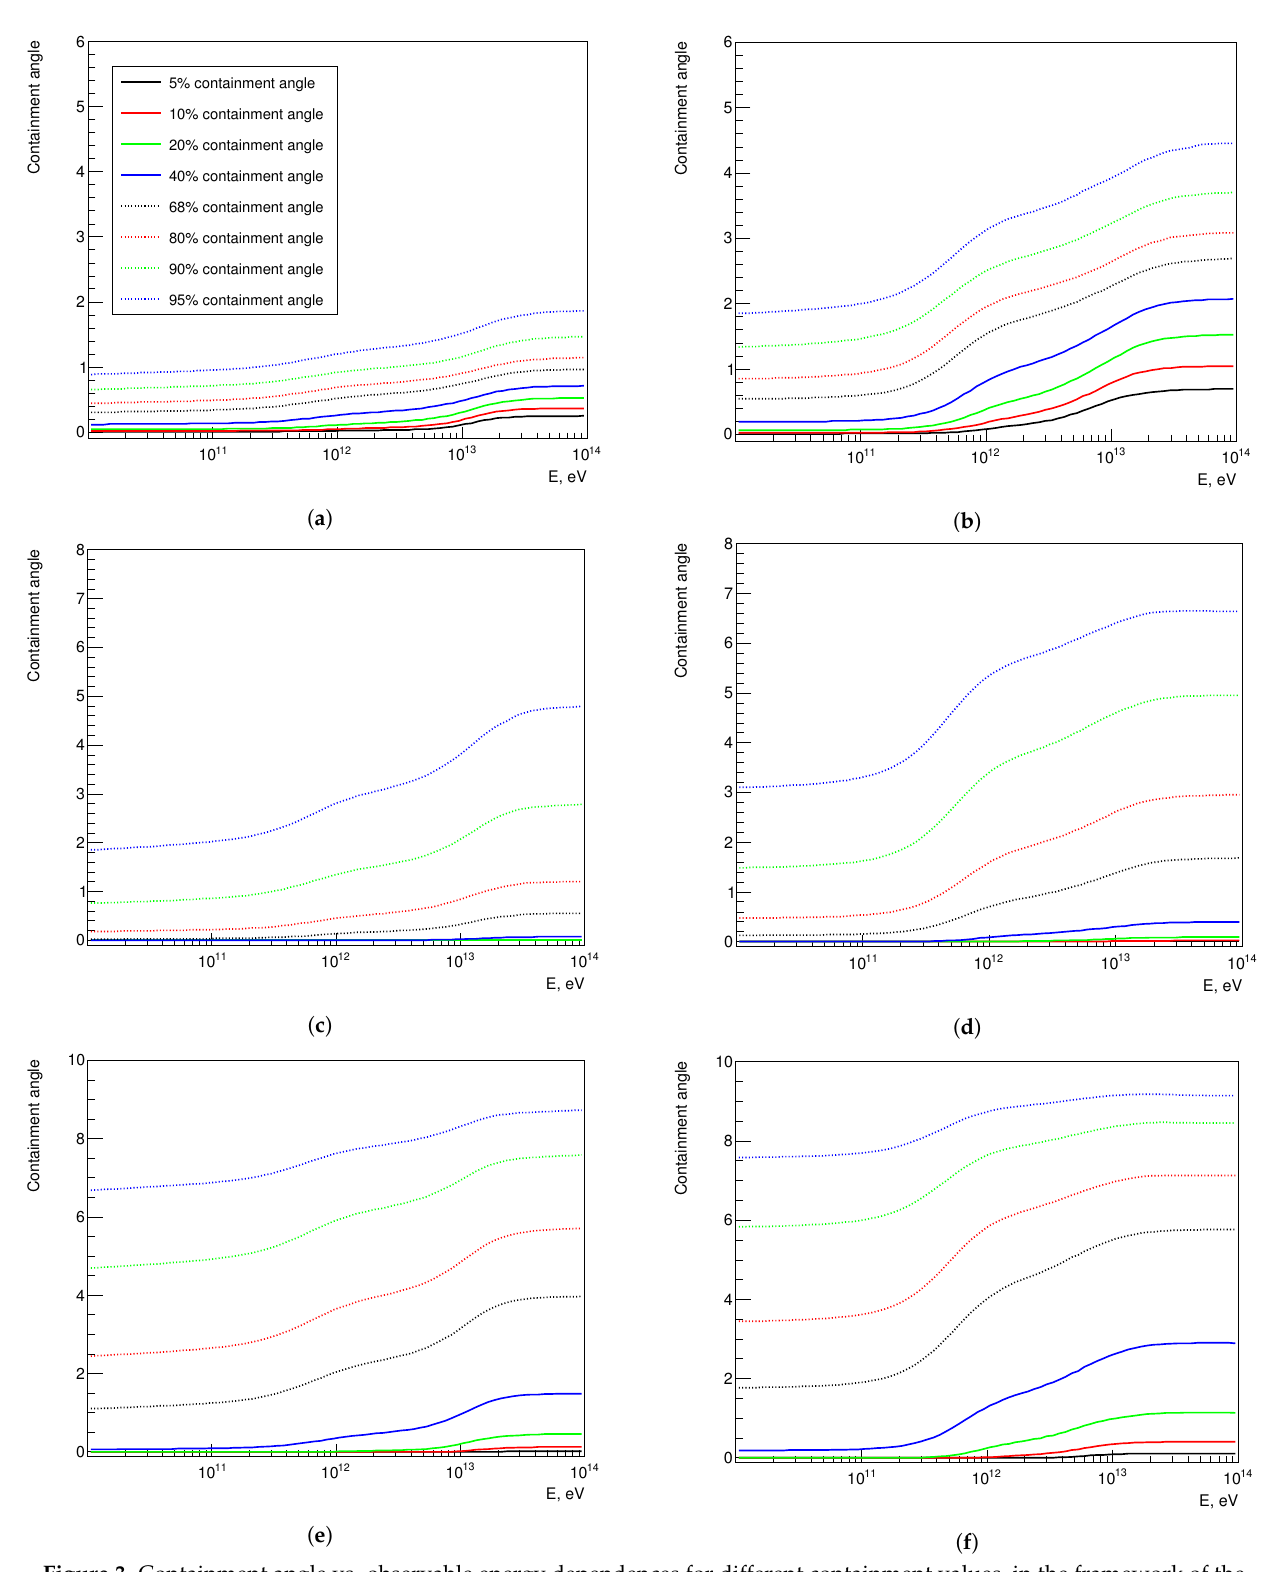
Figure 3. Containment angle vs. observable energy dependences for different containment values in the framework of the IHCM. Black solid curve denotes a 5% containment angle, red solid curve—10% containment angle, green solid curve—20%, blue solid curve—40%, black dashed curve—68%, red dashed curve—80%, green dashed curve—90%, and blue dashed curve—95%. ( a , c , e ) demonstrate the results for the source 1ES 0229+200 and D05, astrophysical (H18), and astrophysicalR (H18) models of EGMF respectively. ( b , d , f )—for the source 1ES 0414+009 and D05, astrophysical (H18), and astrophysical R (H18) models of EGMF